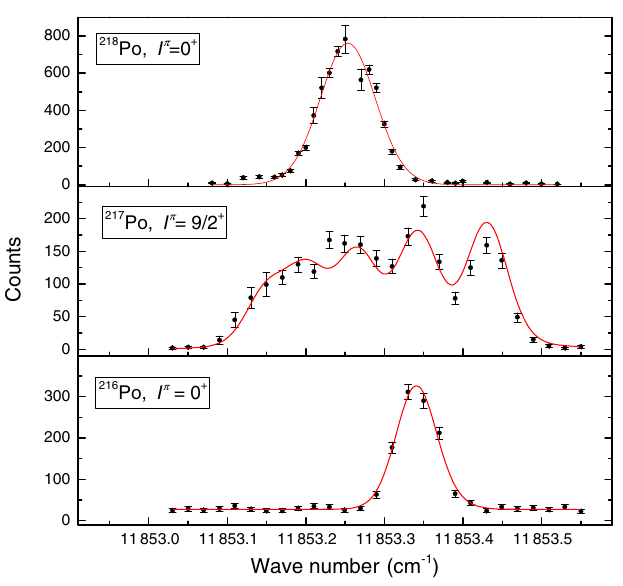
FIG. 10. Laser resonance spectra of the neutron-rich 216 ; 217 ; 218 Po isotopes recorded in the LIST mode. The red curves are the fits to the data according to the nuclear spin given on each